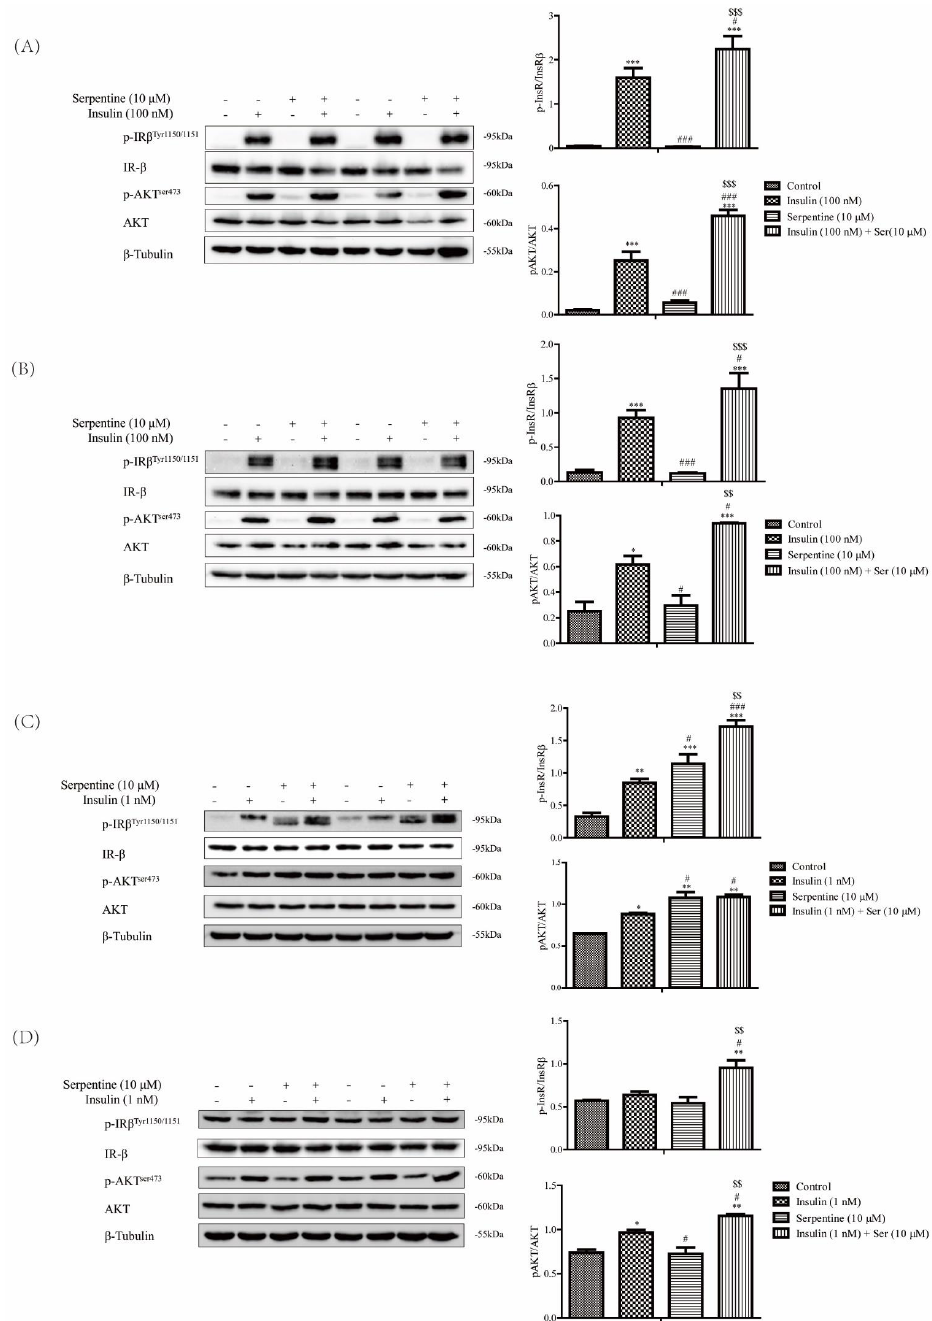
Figure 2. Effects of serpentine on the insulin signaling pathway activated by low-dose insulin. ( A ) Expression of key proteins of the insulin pathway in 3T3-L1 cells following treatment with insulin (100 nM) and serpentine (10 µ M). ( B ) Expression of key proteins of the insulin pathway in C2C12 cells following treatment with insulin (100 nM) and serpentine (10 µ M). ( C ) Expression of key proteins of the insulin pathway in 3T3-L1 cells following treatment with insulin (1 nM) and serpentine (10 µ M). ( D ) Expression of key proteins of the insulin pathway in C2C12 cells following treatment with insulin (1 nM) and serpentine (10 µ M). Data are expressed as mean ± SEM ( n = 4 in each group). * p < 0.05, ** p < 0.01, *** p < 0.001 versus control; # p < 0.05, ### p < 0.001 versus insulin (1 nM) or insulin (100 nM); $$ p < 0.01, $$$ p < 0.001 versus serpentine (10 µ